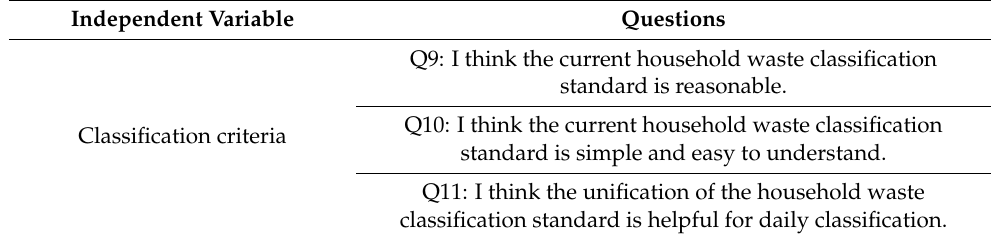
Table 2. Classification criteria questions.